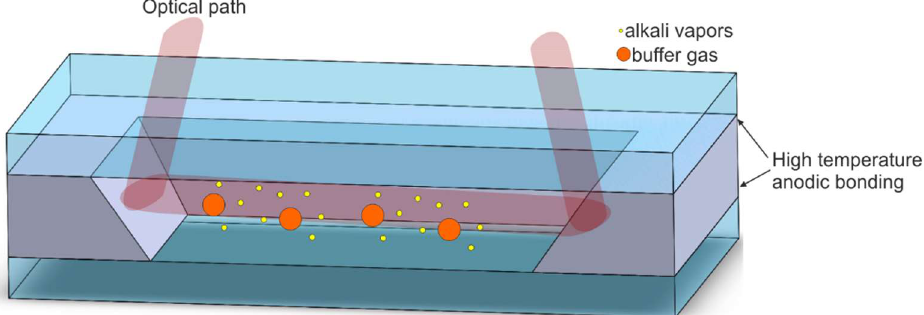
Figure 16. The MEMS cell with reflective sidewalls (pill dispenser, microstrainer, and grating not visible).